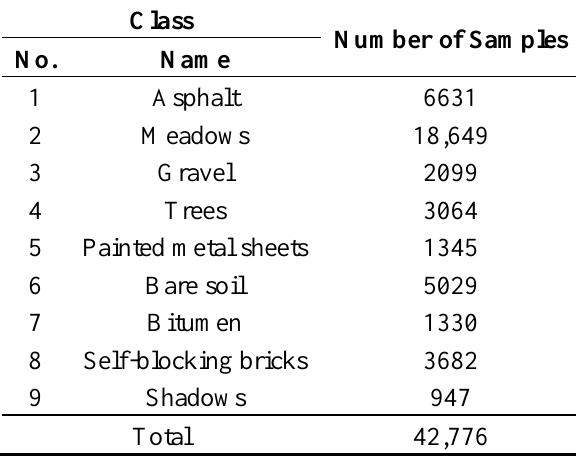
Table 2. Per-class samples for the University of Pavia